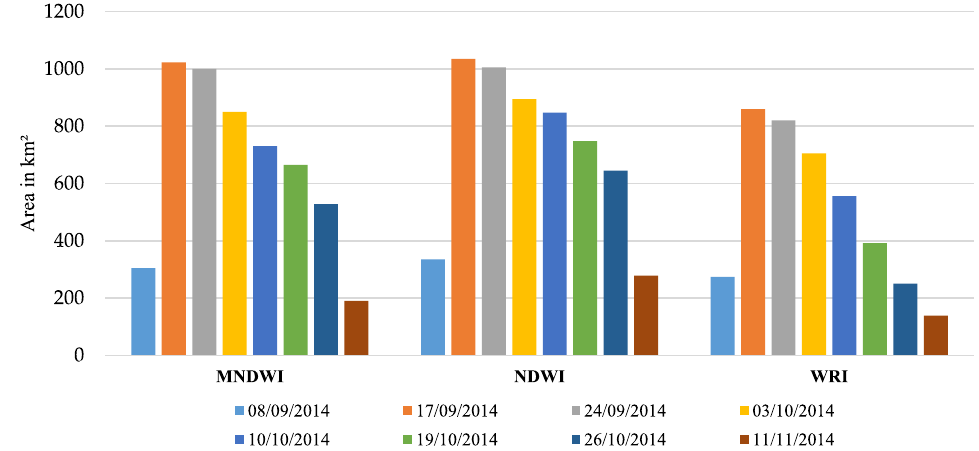
Fig. 6 Flood inundated areas calculated using MNDWI, NDWI, and WRI indices on different